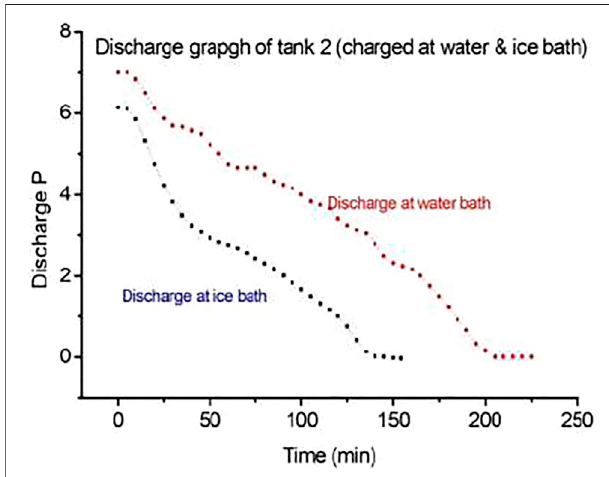
FIGURE 5 | Discharge curves of MH tank 2 at 20 ° C water bath and ice